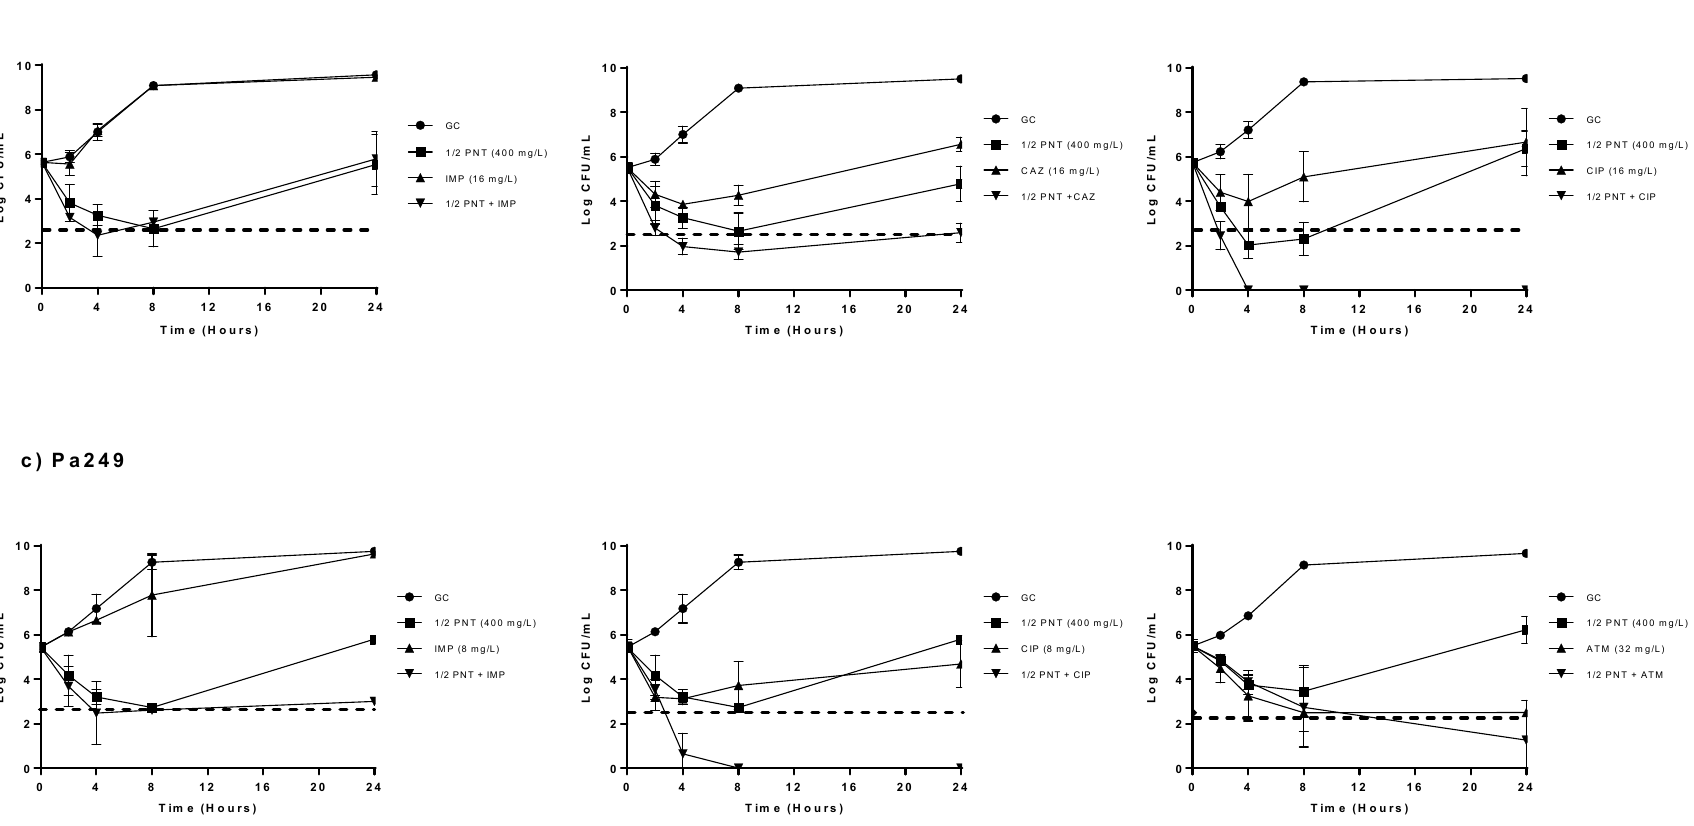
Figure 1. Time-kill curves for pentamidine at 1 / 2 × MIC in combination with antibiotics against the clinical strains Pa29, Pa206 and Pa249. ( a ) Pa29, ( b ) Pa206 and ( c ) Pa249; GC: growth control, filled circles; pentamidine (PNT, 1 / 2xMIC), filled squares; antibiotics alone (IMP: imipenem, CAX: ceftazidime, CIP: ciprofloxacin; ATM: aztreonam, 1xMIC), filled triangles; PNT (1 / 2xMIC) + antibiotics (1xMIC), filled inverted triangles. Dotted line: indicates when and how long a compound alone or a combination has bactericidal activity.